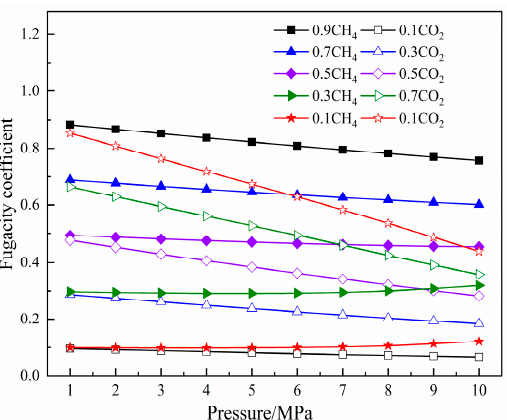
Figure 2. The relationship between the fugacity coefficient of gas and its pressure.